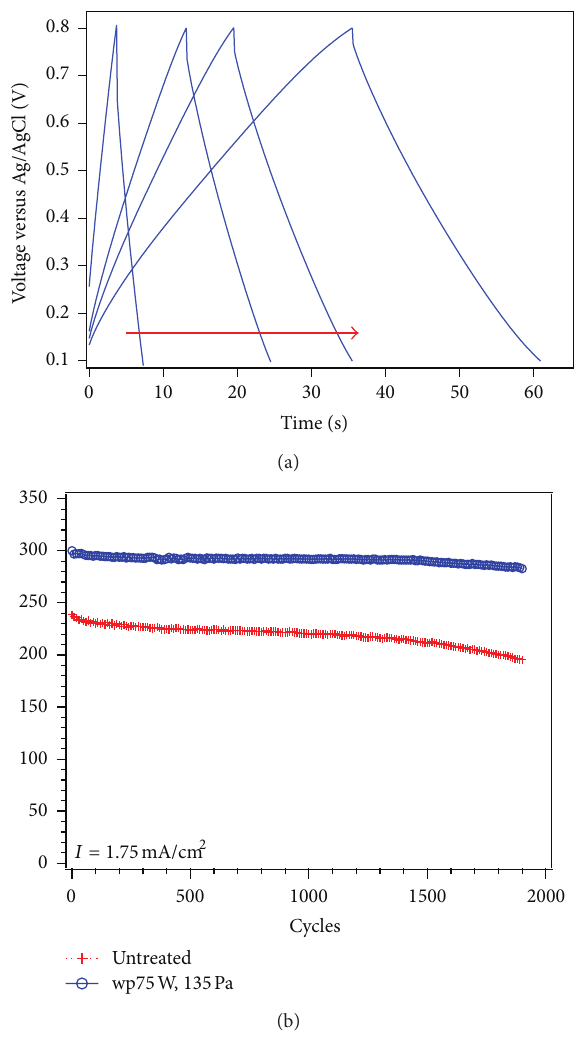
Figure 7: (a) Charge/discharge curves at different current densities from1.75,0.70,0.52,and0.35 mAcm −2 ,asindicatedbythearrow,for wpCNTs/MnO 2 (75W, 135 Pa). (b) Galvanostatic charge/discharge cyclic stability in the 0.1–0.8 V